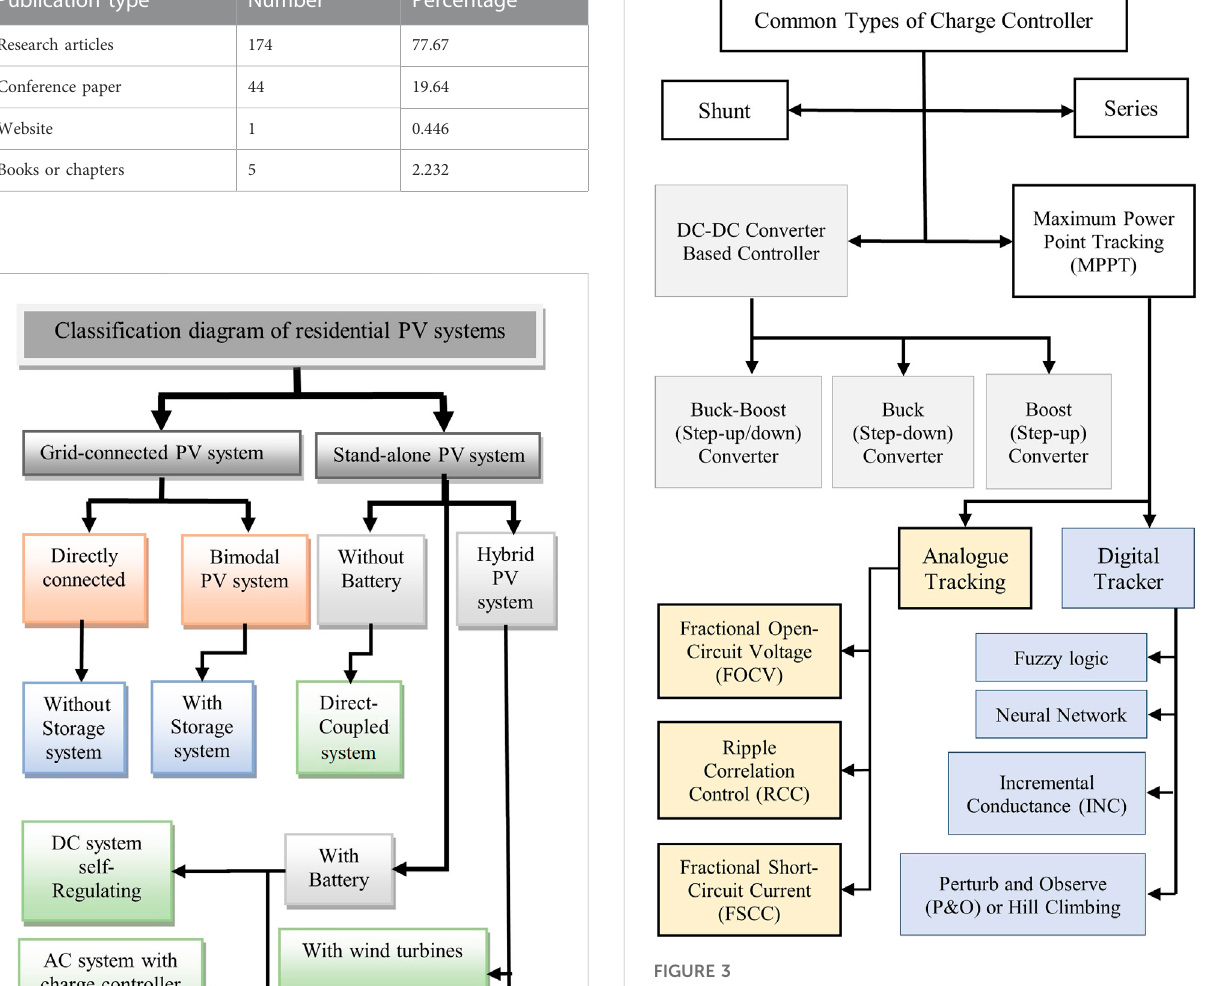
FIGURE 3 Common types of solar charge